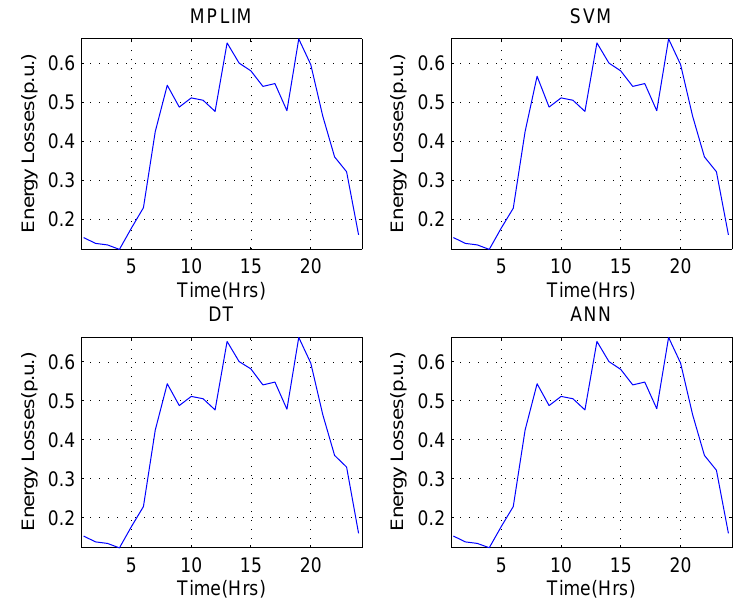
Figure 7. Energy losses calculated for 24